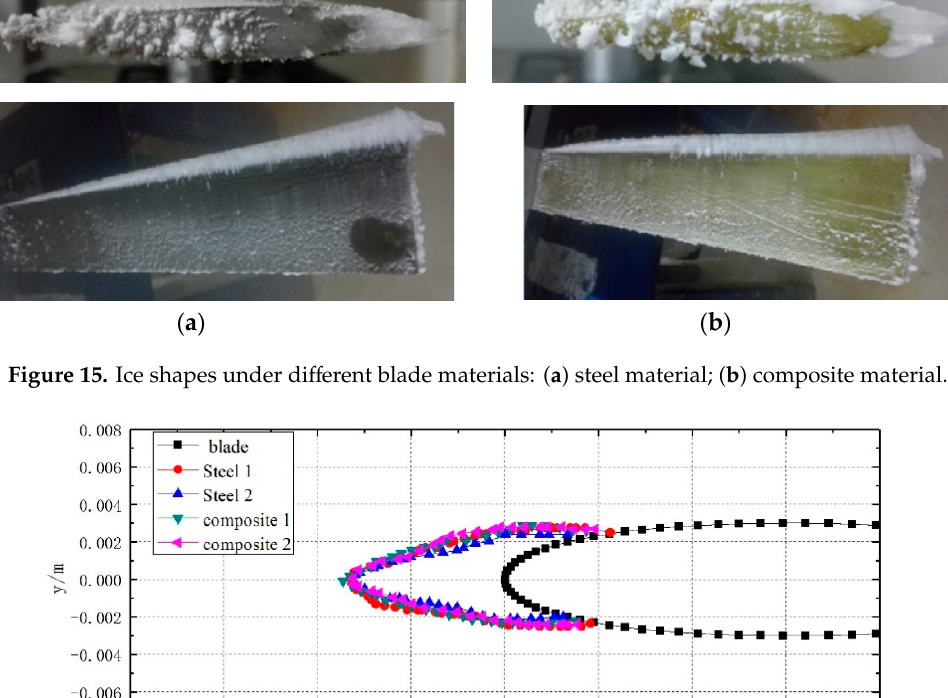
Figure 14. Blade distribution of different materials.